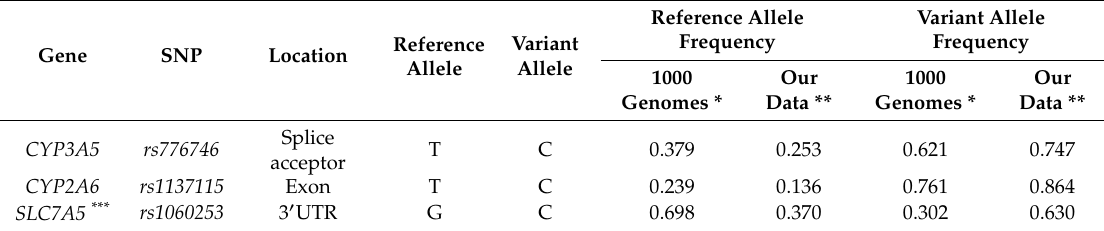
Abbreviations: C max , maximum plasma concentration; AUC last , area under the concentration curve from time zero to the last quantifiable time point; SNP, single nucleotide polymorphism. The allele frequency was calculated using the 1000 Genomes Project * data and our data **. SNP data were retrieved from dbSNP. *** C max only.